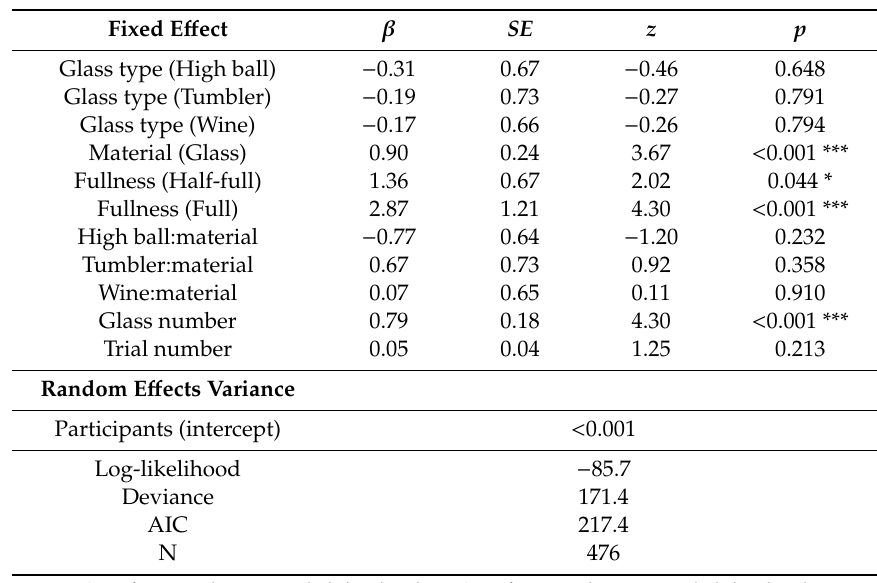
Table 2. GLMM output for putdown 2, when the glass is placed on the tray. Structure of model re- ported here: glmer(guidance ~glass type*material + fullness + glass number + trial number + (1 + material + fullness + glass number || participant)).